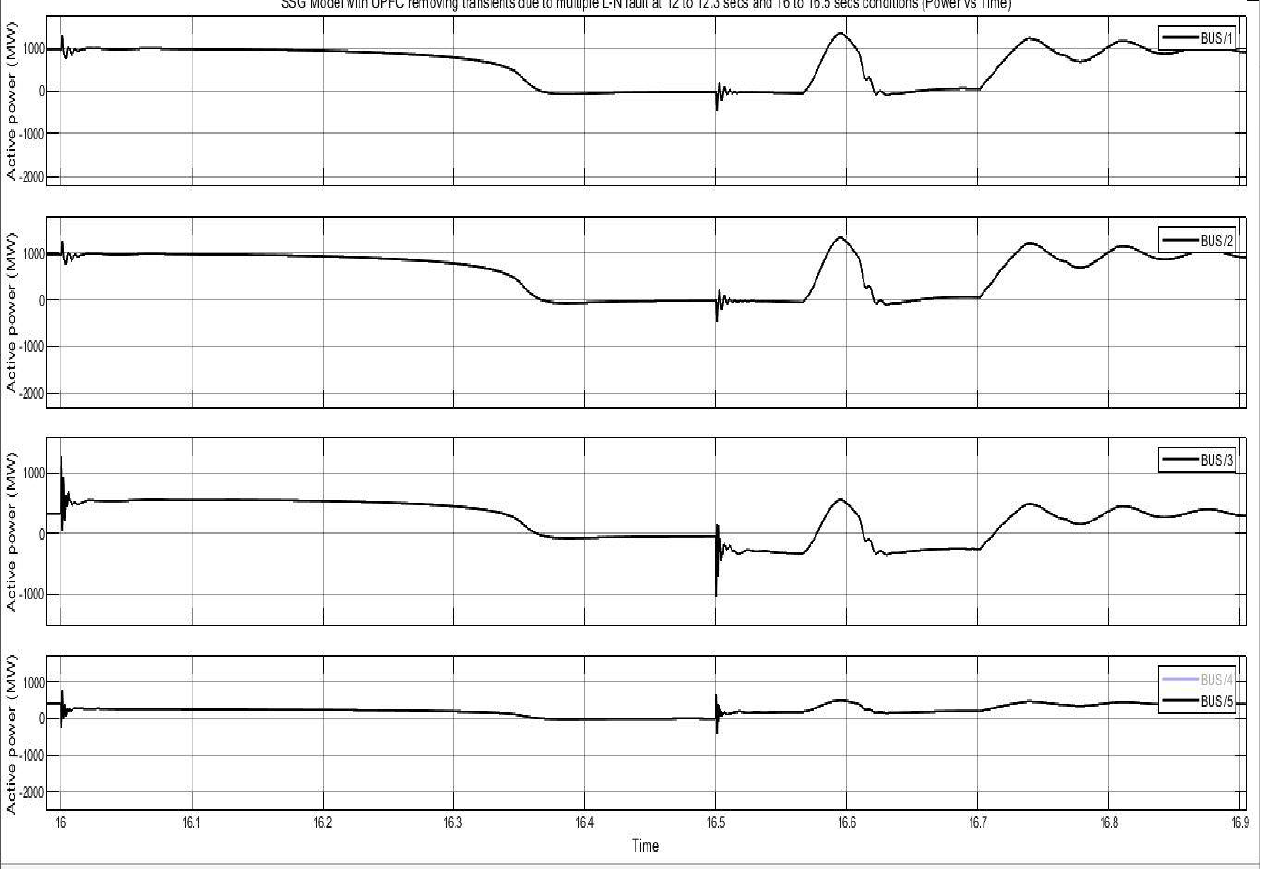
Figure 22. Transient stability being provided by UPFC at multiple L-G faults from 16 to 16.5 s (Bus 1 to Bus 5).